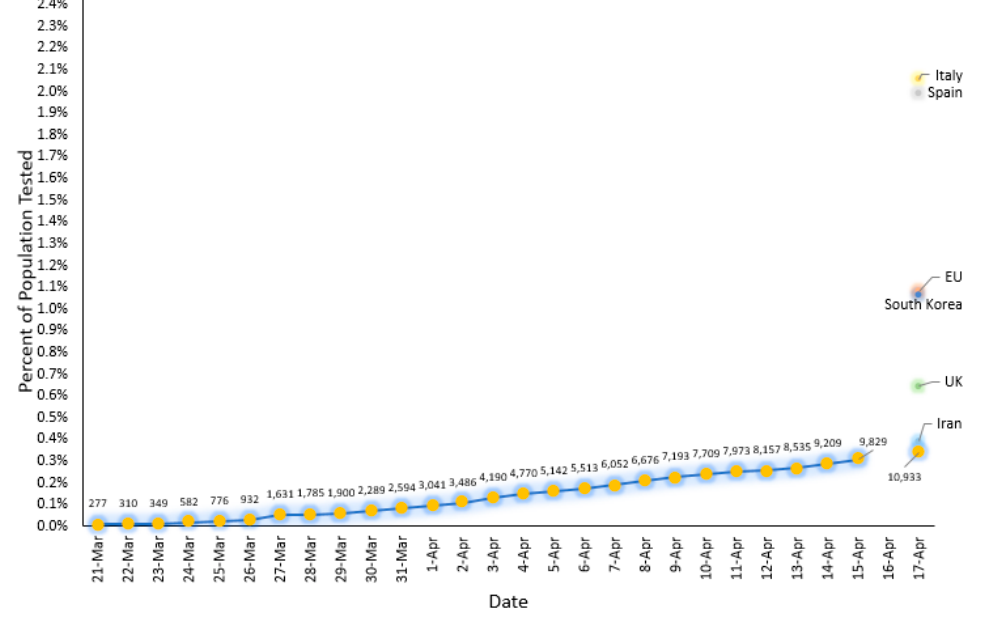
Figure 5. Diagnostic testing capacity as measured by percent of the population tested in Puerto Rico by sample collection date. Data points from other countries are included for reference (Source: data from the Puerto Rico Department of Health and The New York Times gathered and analyzed by Drs. Linnette Rodríguez and Héctor Colón).